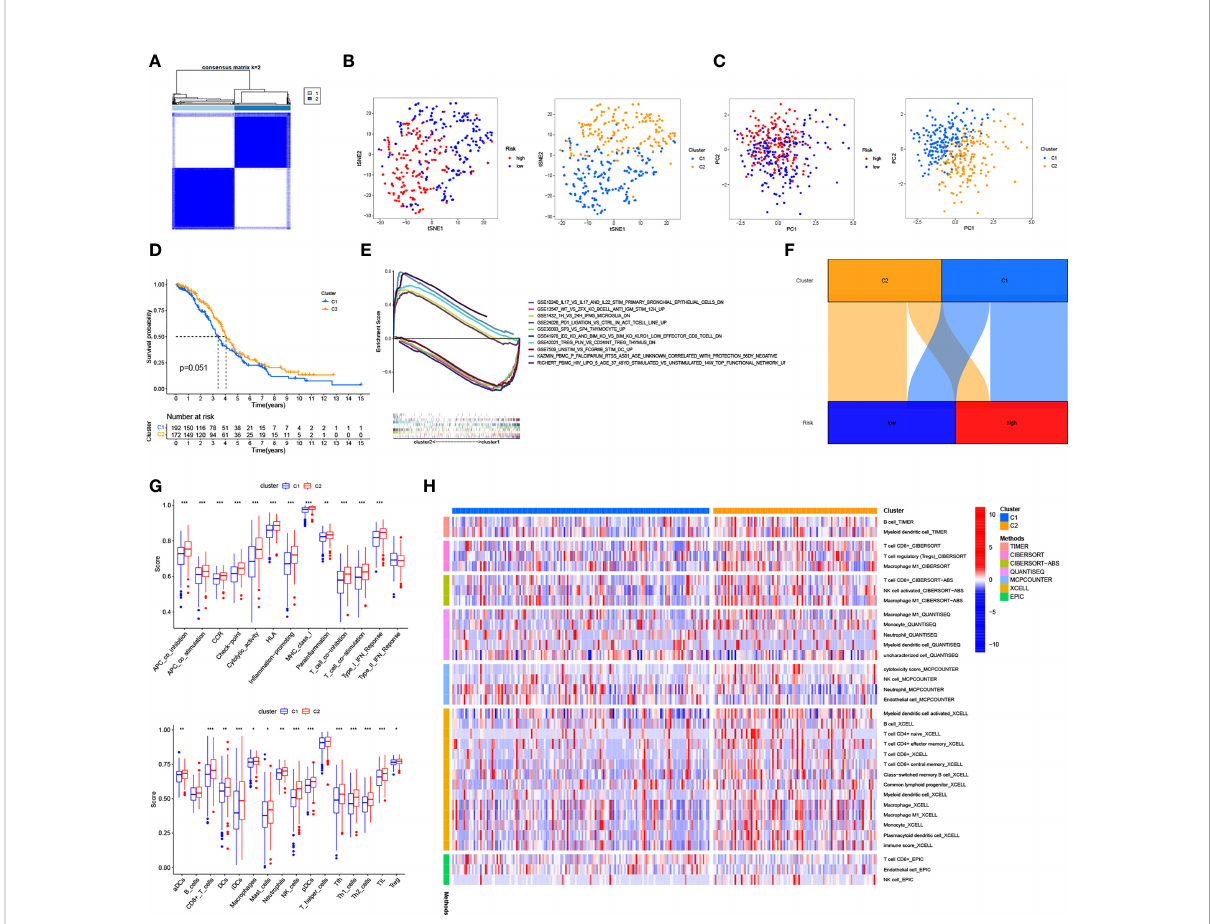
FIGURE 8 Cold and Hot Tumor Cluster Screening. (A) According to ConsensusClusterPlus, OC patients are split into two clusters. (B) Risk groups and clusters of T-SNE. (C) The PCA for risk groups and clusters. (D) Survival curves of Kaplan – Meier for OS in clusters. (E) The GSEA of immunologic signature in clusters. (F) The Sankey diagram of risk groups and clusters. (G) The ssGSEA scores in clusters. (H) The heat map shows immune cells grouped in clusters. *: p < 0.05. **: p < 0.01. ***: p <